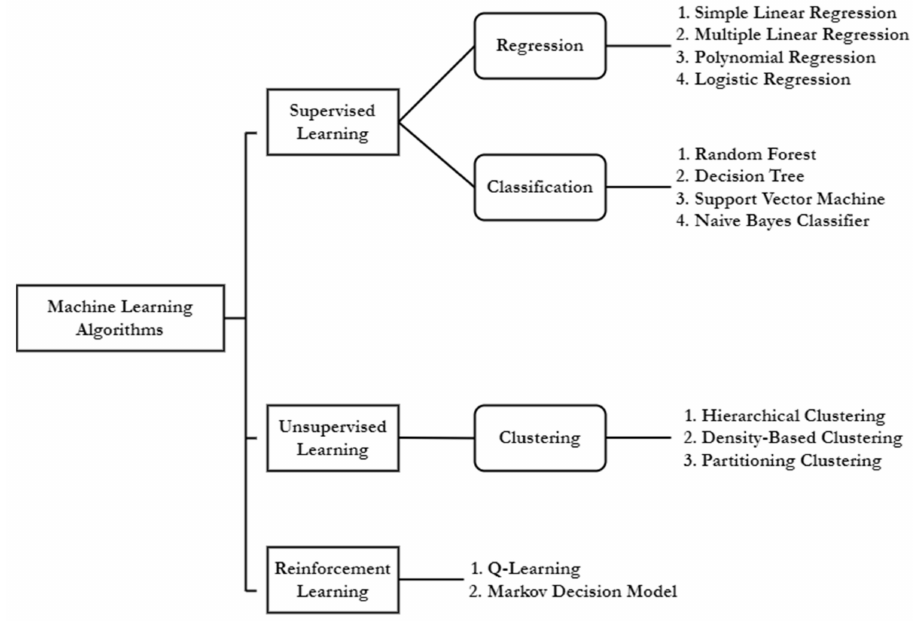
Figure 4. Categories of ML algorithms with key